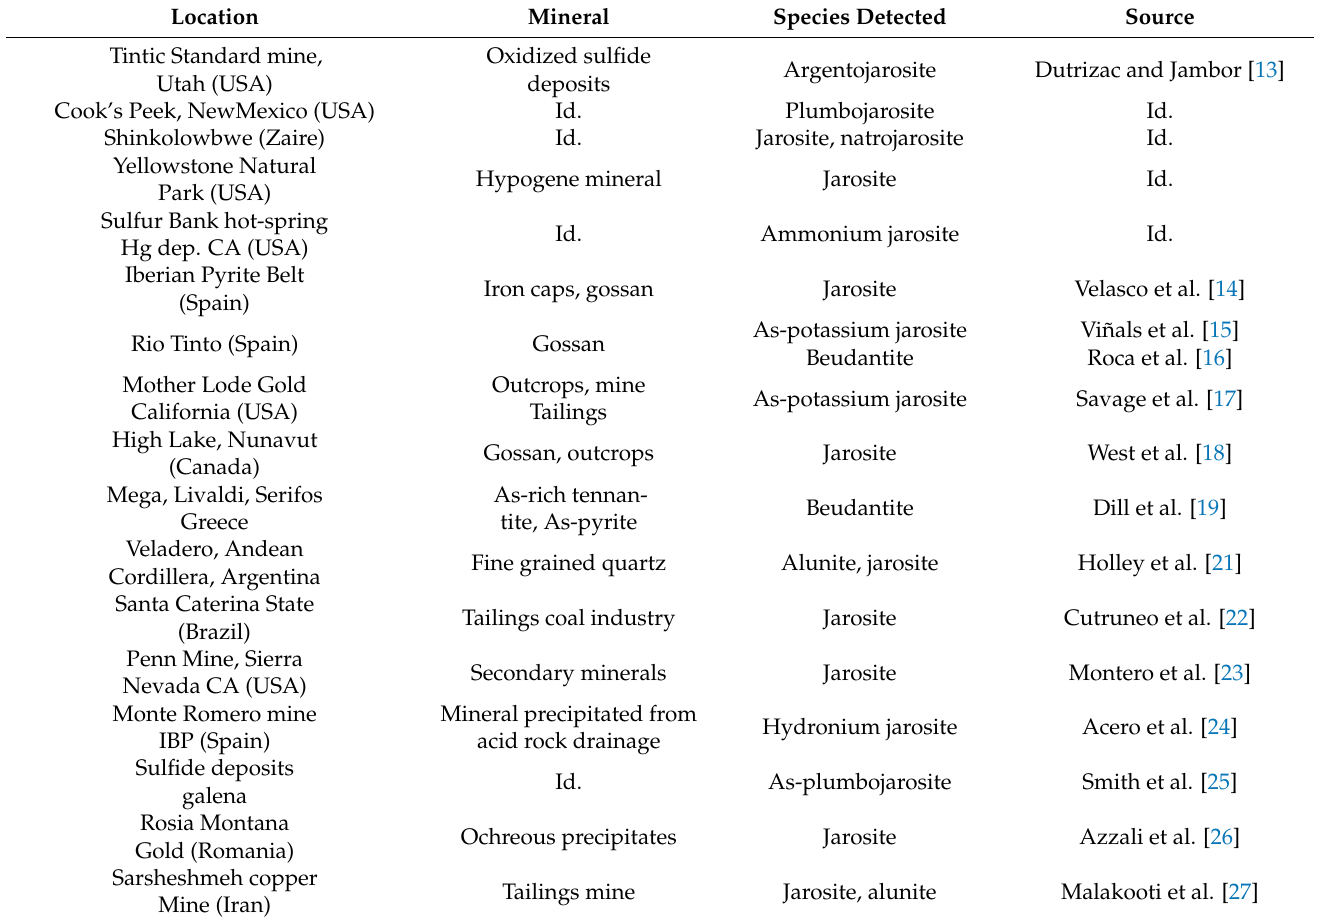
Table 2. Summary of works about natural jarosite